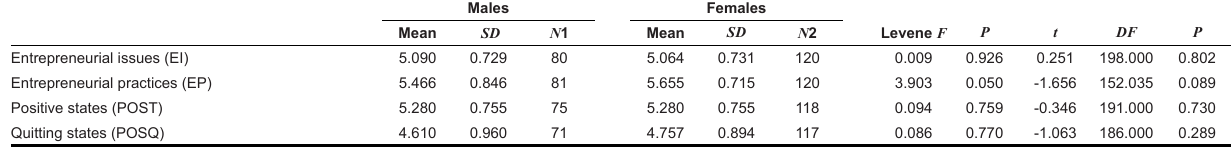
TABLE 11 t -test: Comparison of gender groups in respect of entrepreneurship orientation